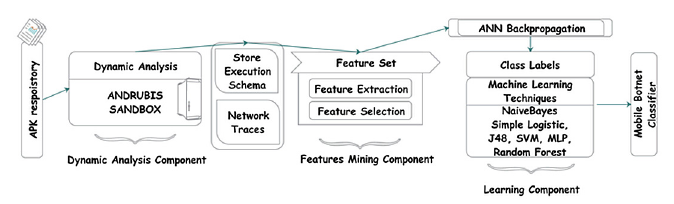
Fig 2. SMARTbot Framework